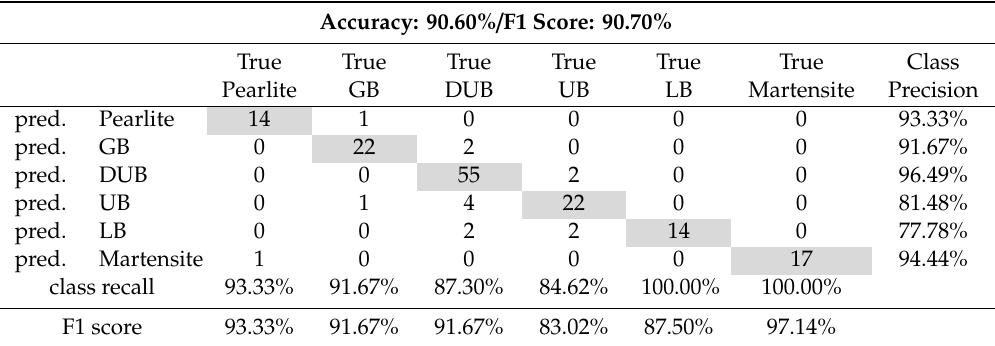
Table 6. Confusion matrix for the classification using a combination of Haralick parameters and multi-scale local binary pattern with a quadratic kernel SVM, without feature selection.